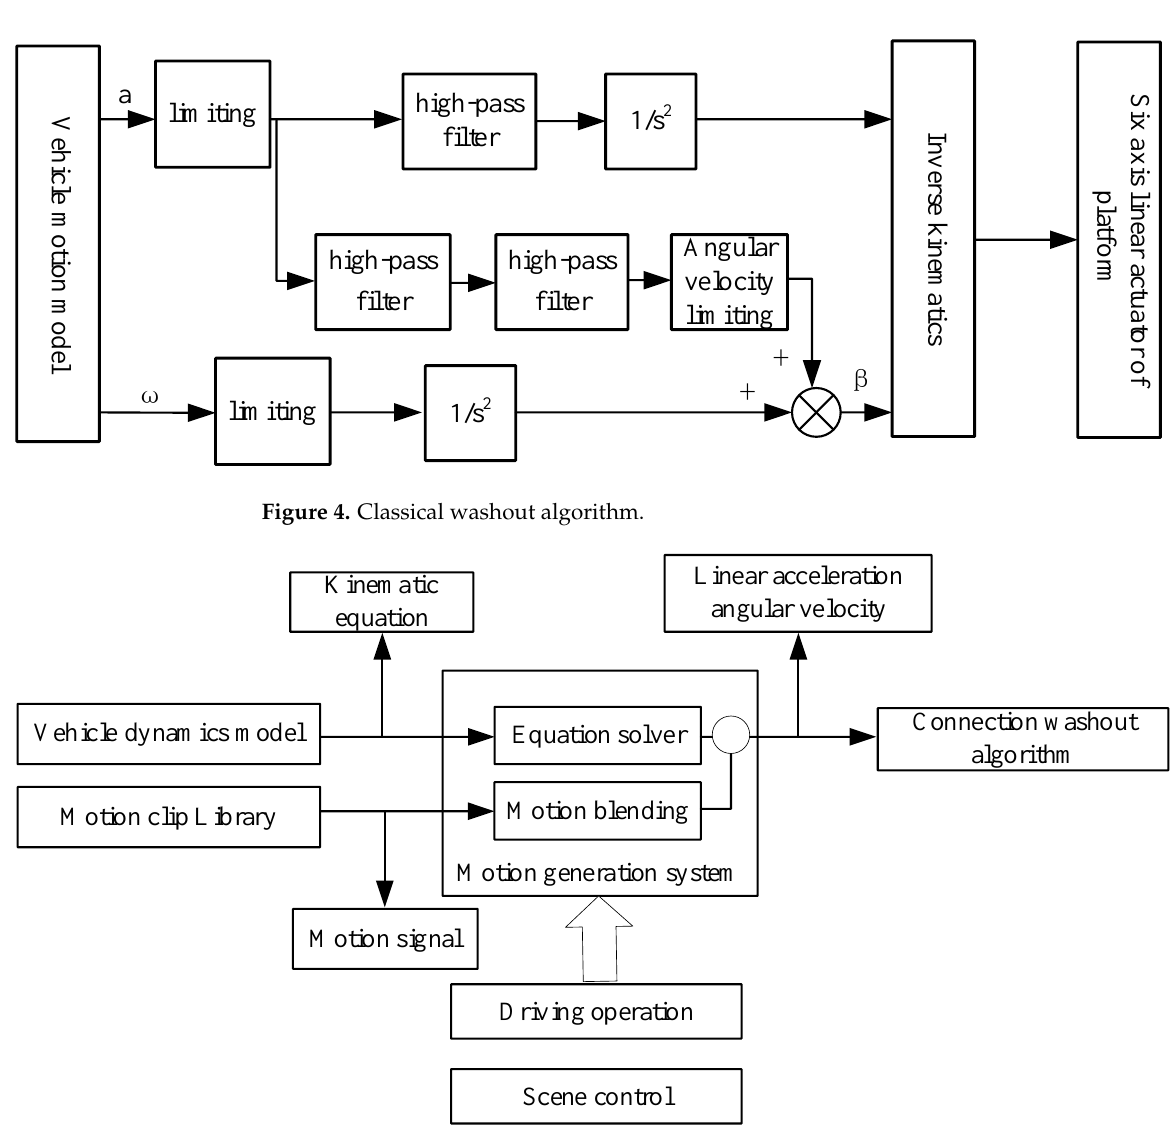
Figure 5. Motion blending technology in the trolley driving simulator.